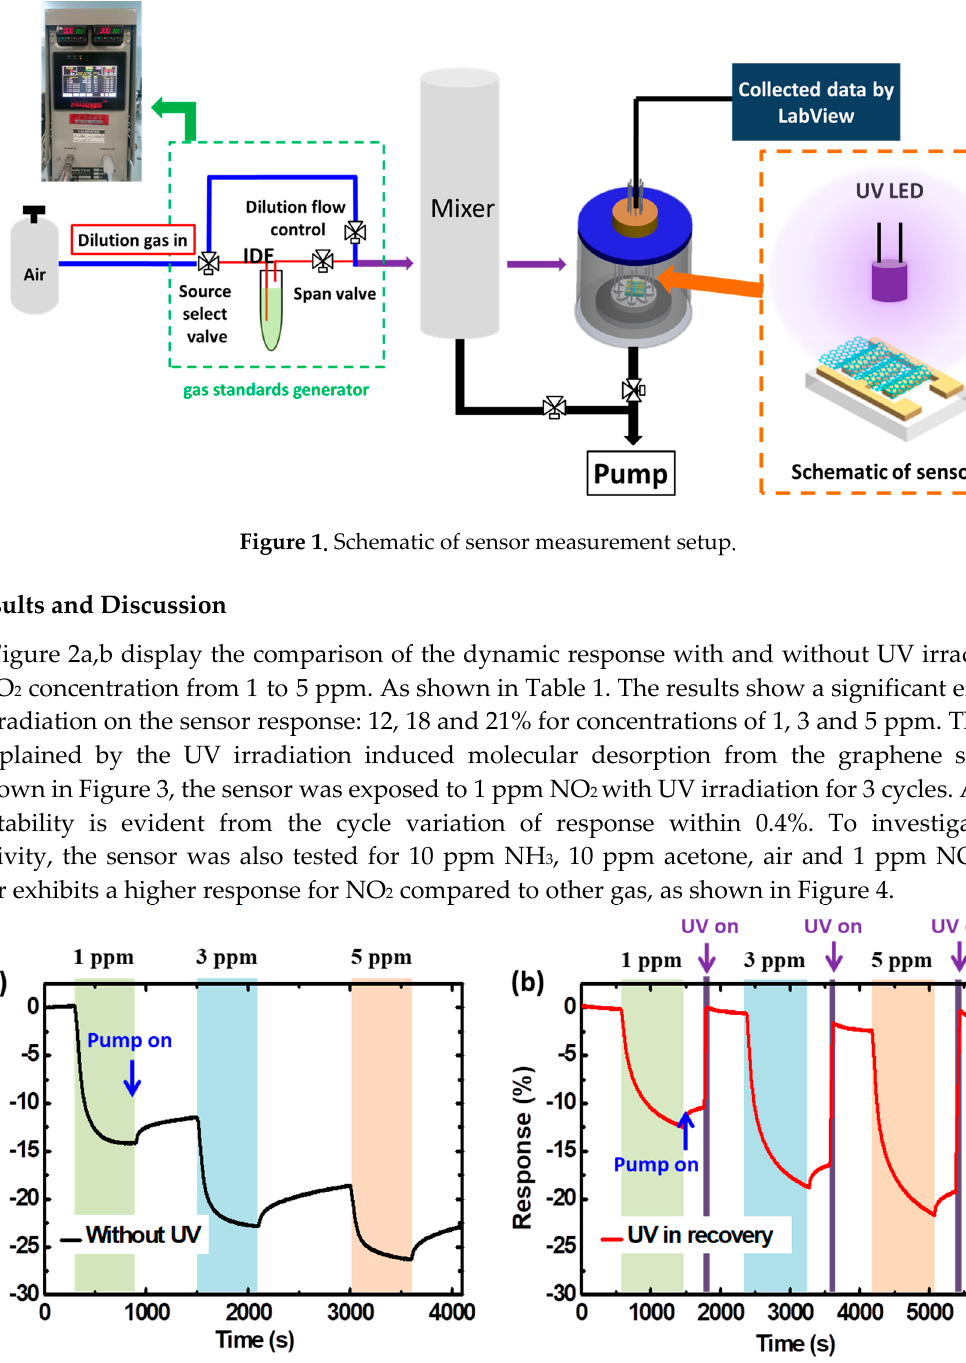
Figure 2 . Dynamic responses for different NO 2 concentrations for ( a ) without and ( b ) with UV